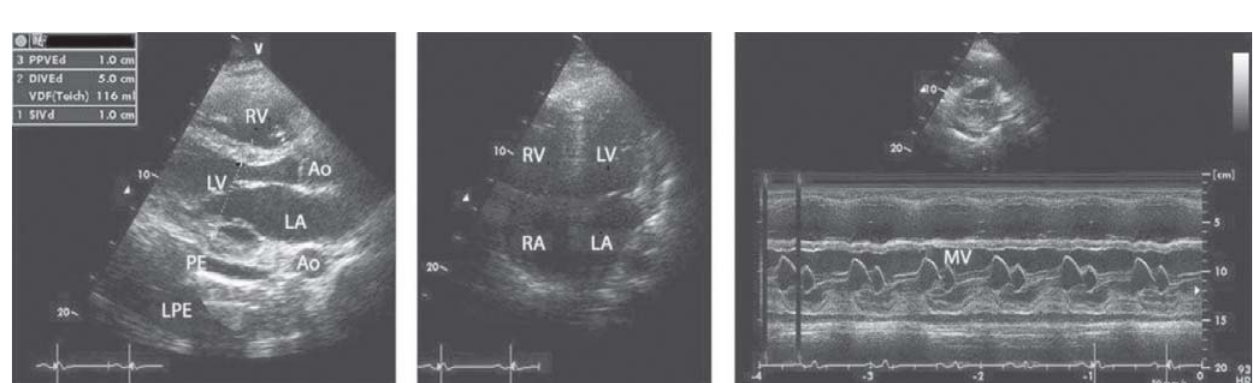
Fig. 2 - A poor contracting LV, with an enlarged RV protruding in the outflow tract of the LV. The calculated EF of the LV was 40%. LPE=Left Pleural Effusion, PE= Pericardial Effusion